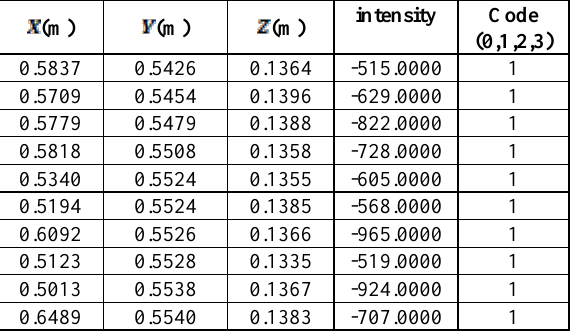
Table 2. Fragment of outputfile.txt with code column The third modification is visible on the images. Selected fragment and their analysis with modified OptD method of basements for object1 are presented in Figure 4 and Figure